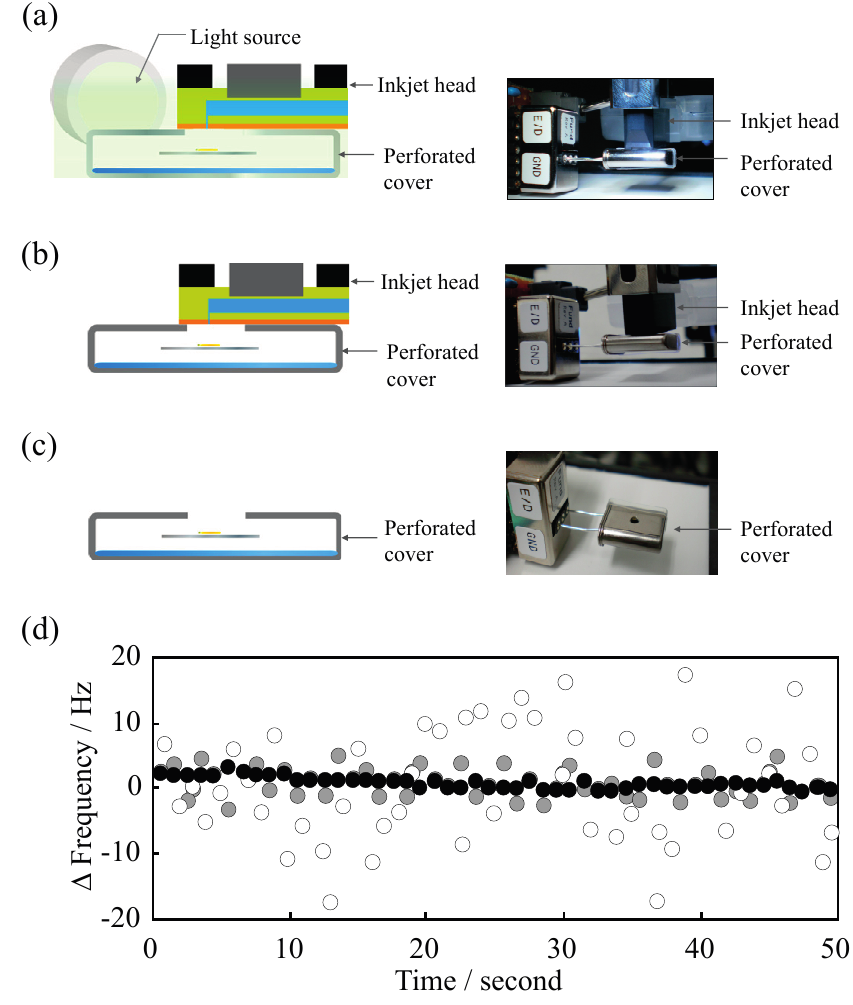
Figure 2. Elimination of external sources of background noise using the following methods: ( a ) perforated stainless-steel cover is capped with the flat surface of the inkjet head and light irradiation was supplied for a constant thermal energy ( ● ); ( b ) perforated stainless-steel cover is capped with the flat surface of the inkjet head without light